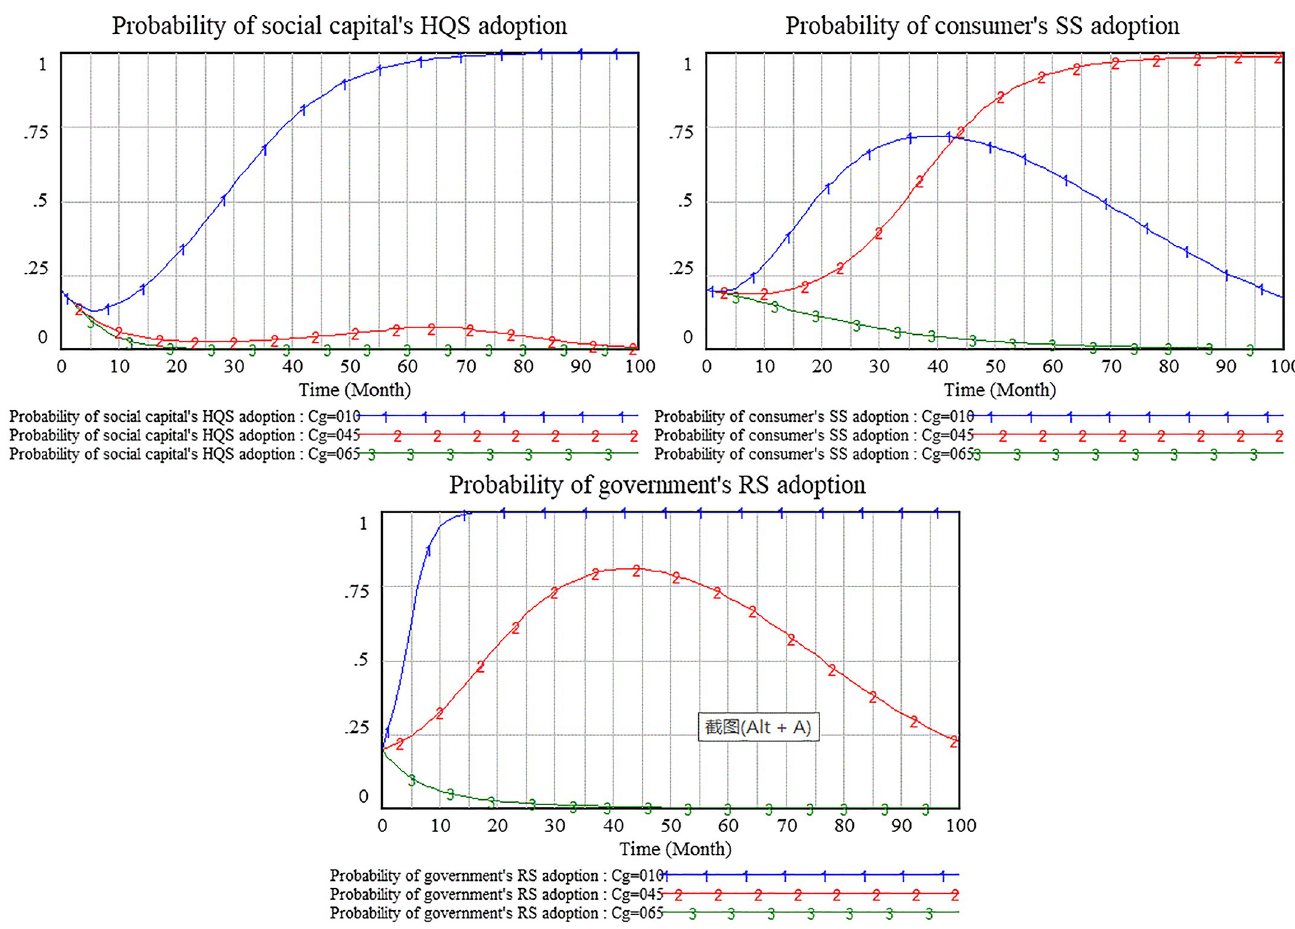
Fig 21. Impact of different regulation cost of